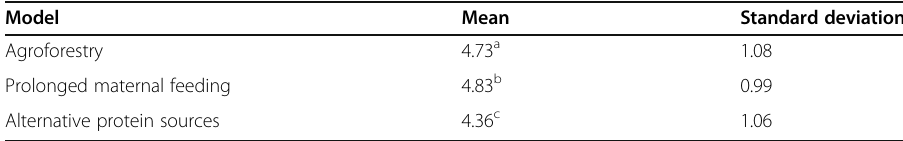
Table 11 Descriptive statistics for attitude towards behaviour (all countries) Model Mean Agroforestry Prolonged maternal